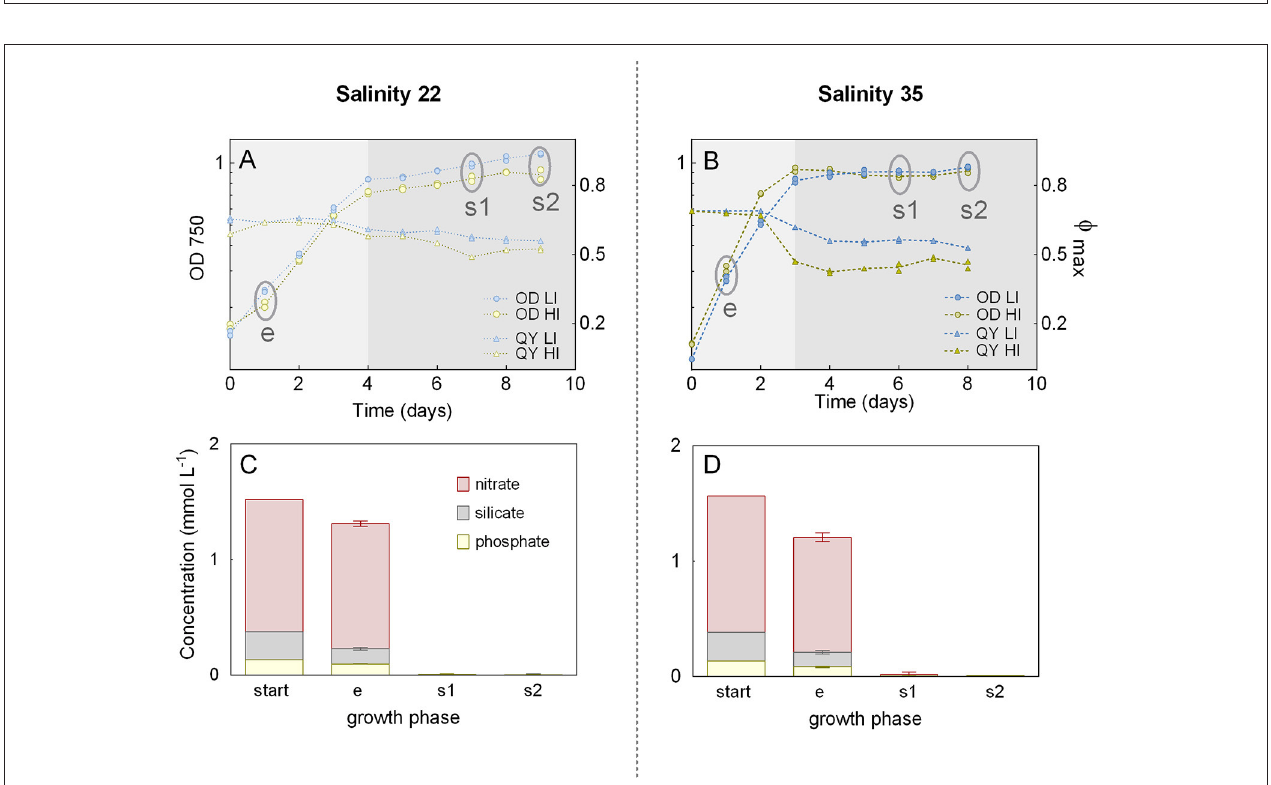
FIGURE 2 | Growth during batch experiment. Batch cultures of the diatom Attheya septentrionalis grown at four conditions (combinations of low and high salinity [22 and 35] and irradiance [50 and 200 µ mol photons m − 2 s − 1 ] with two biological replicates for each condition). (A,B) Optical density (OD 750 ) based growth curves and maximum quantum yields (QY, 8 max) for low and high salinities, respectively. Circles indicate sampling time points (e, exponential phase; s1, first stationary phase; s2, second stationary phase). LI, low irradiance; HI, high irradiance. (C,D) Superimposed nutrient concentration in the media at the start of the experiment and during exponential (e) and stationary (s1 and s2) sampling time points for low and high salinities, respectively. Values are the averages and standard deviations from samples of the respective salinity.